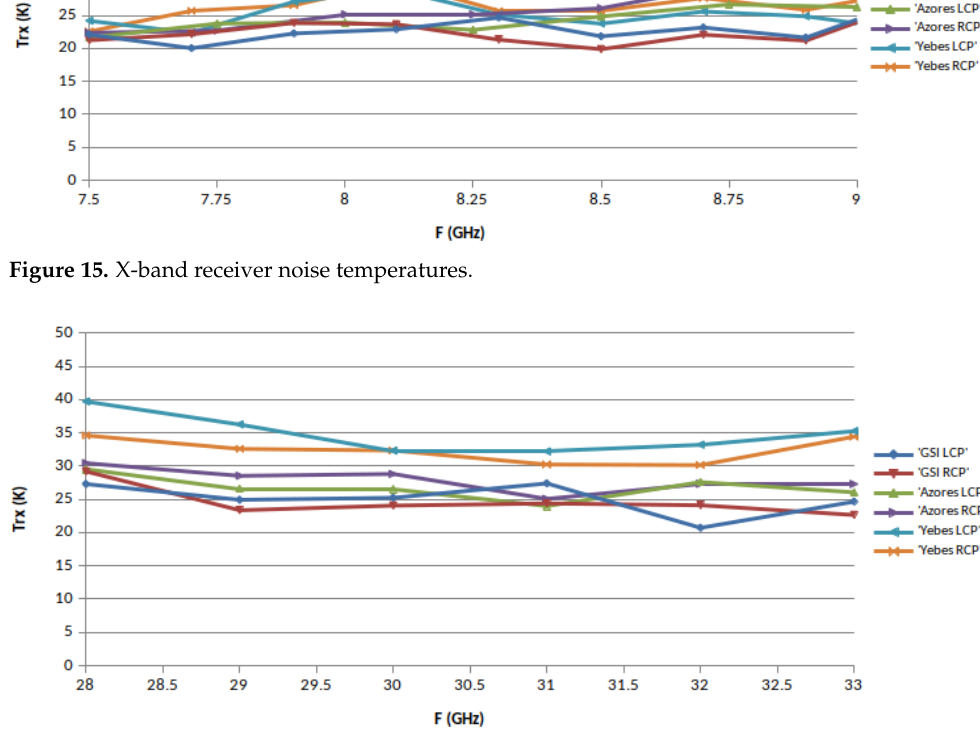
Figure 16. Ka-band receiver noise